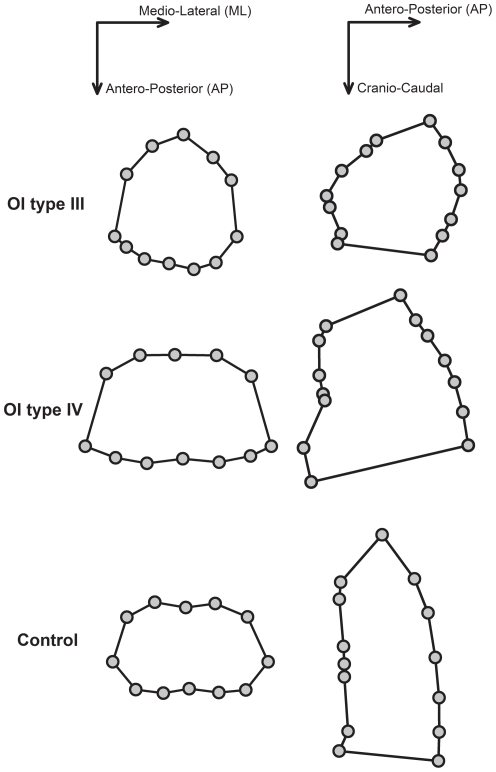
Transversal and sagittal sections of OI type III, OI type IV and controls.Markers' projection on the transversal (left) and sagittal (right) views of the markers (at xiphoid and sternal level, respectively) on three representative subjects: OI type III (top), OI type IV (middle) and healthy control (bottom).